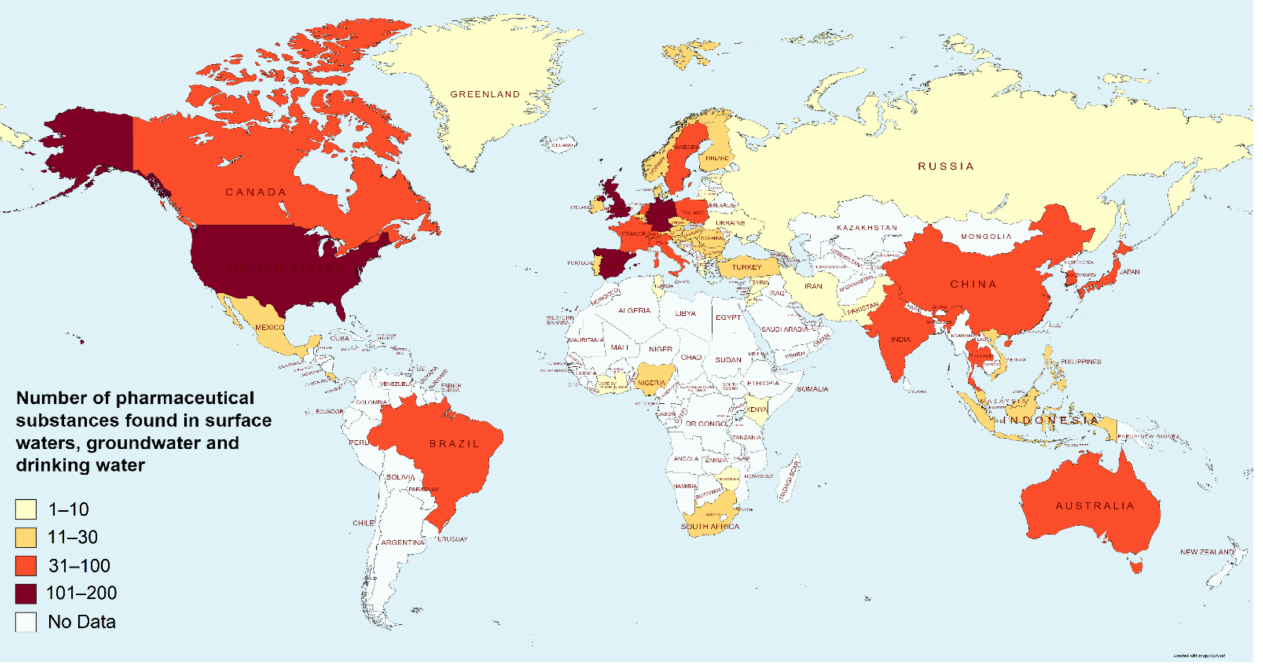
Figure 1. Global occurrence of